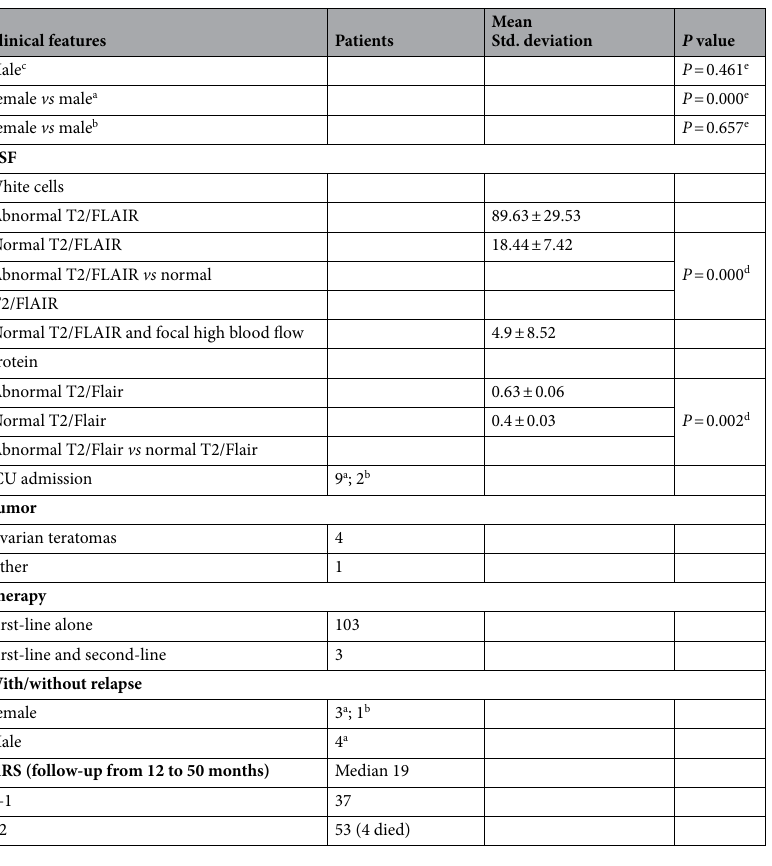
Table 1. Clinical Characteristics of patients with anti-NMDAR encephalitis. Std. deviation standard deviation, mild DPS mild diffuse polymorphic slowing, moderate DPS moderate diffuse polymorphic slowing, SDPS severe diffuse polymorphic slowing, EDB extreme delta brush, ASL arterial spin labeling, CSF cerebrospinal fluid. a High CSF antibody titer (1:10 or 1:32). b Low CSF antibody titer (1:1 or 1:3.2). c Low CSF antibody titer (1:1 or 1:3.2) vs high CSF antibody titer (1:10 or 1:32). d Independent-sample t test. e Mann–Whitney U test. Onset denotes the number of patients with the clinical symptoms manifesting onset